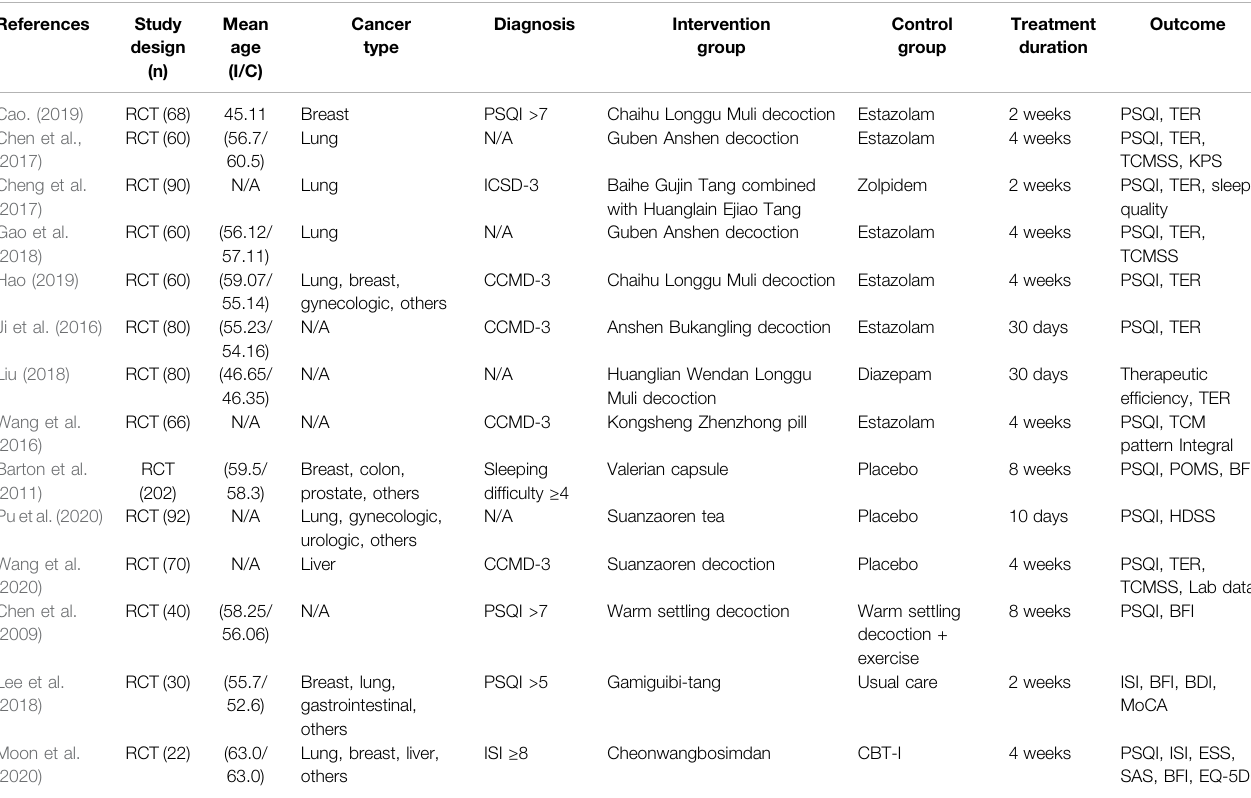
TABLE 1 | Basic characteristics of included